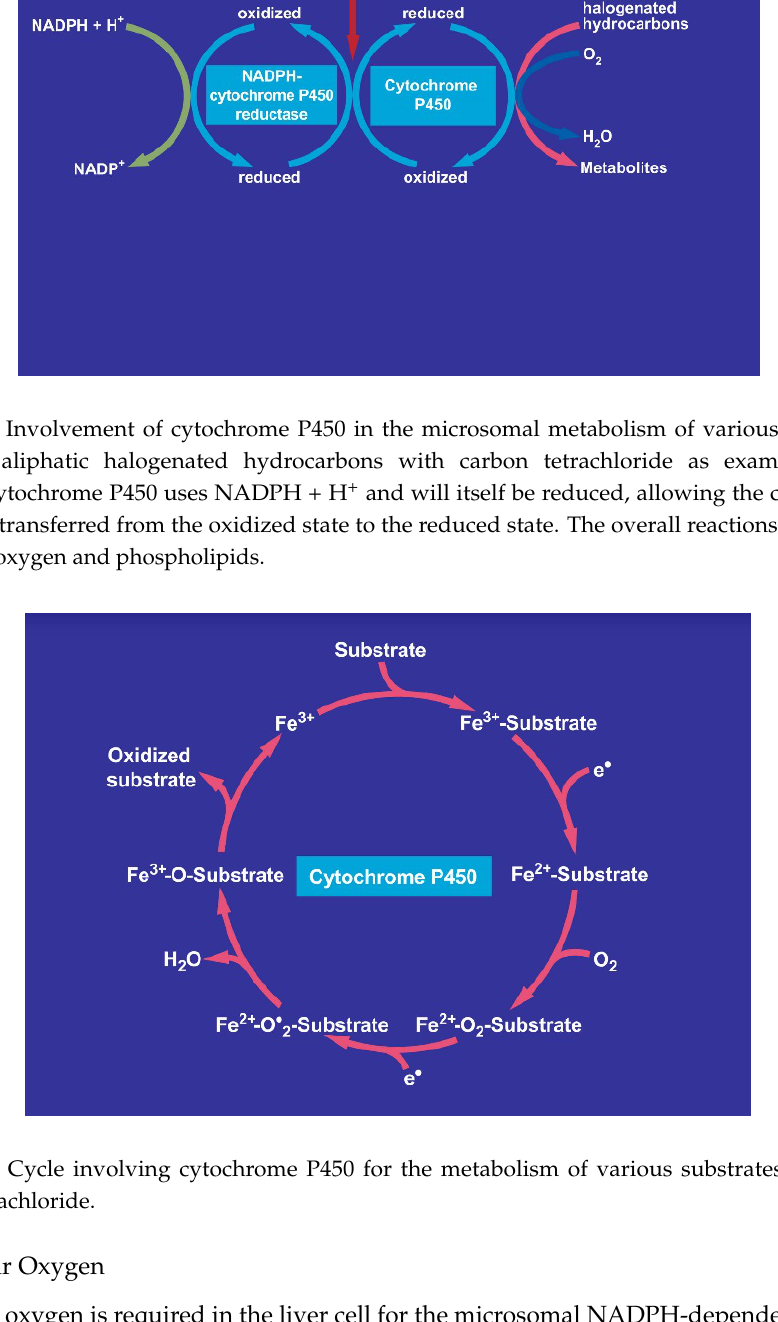
Figure 19. CCl 4 metabolized by cytochrome P450 2E1 similarly to other toxins such as vinyl chloride and dimethylnitrosamine.